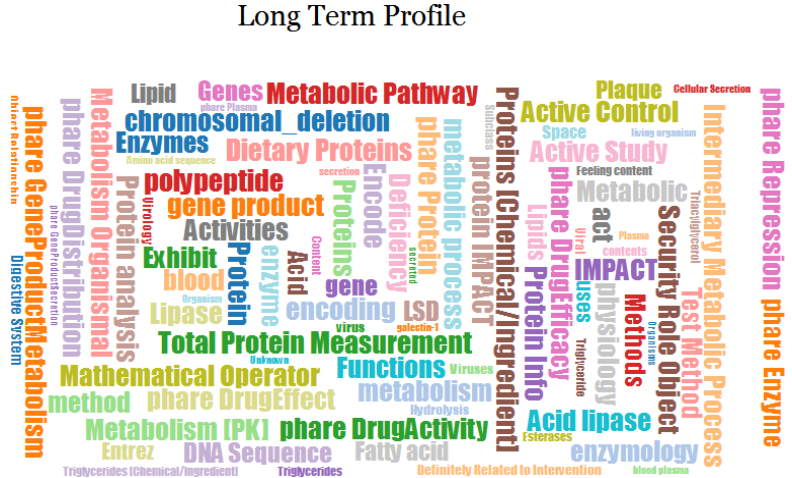
Figure 5. Long Term Profile for user